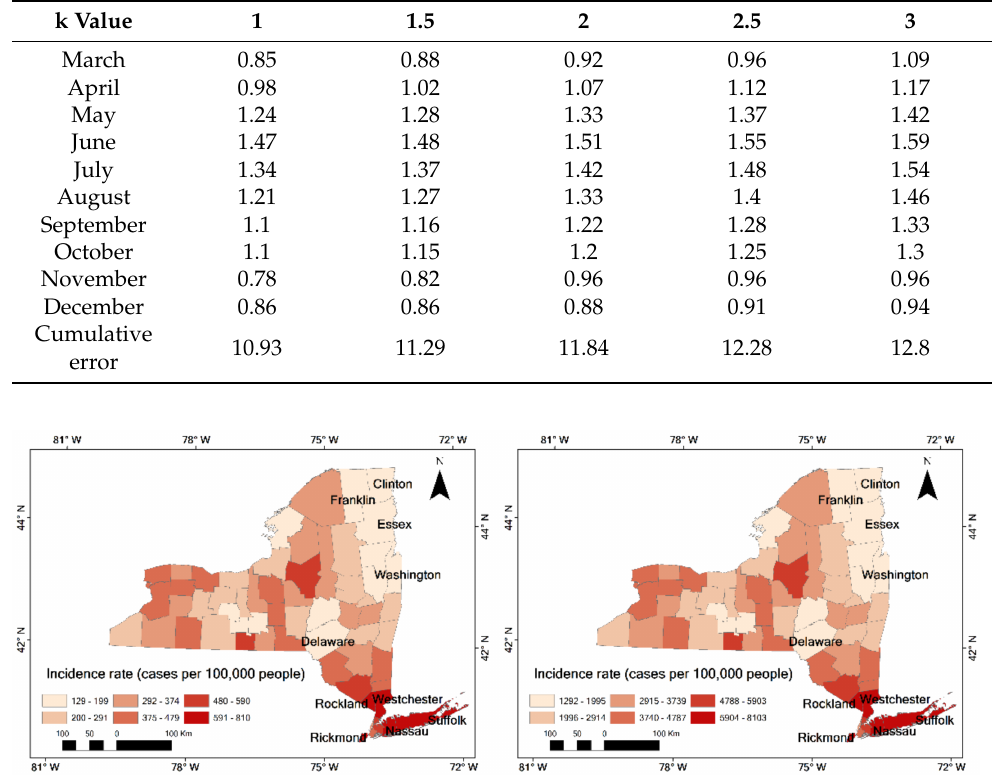
Figure 2. Distribution of monthly average and cumulative incidence rate of COVID-19 in New